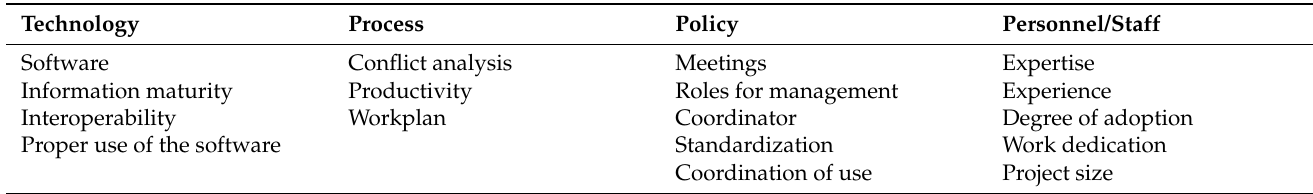
Table 1. Definitive variables grouped by parameters or categories.